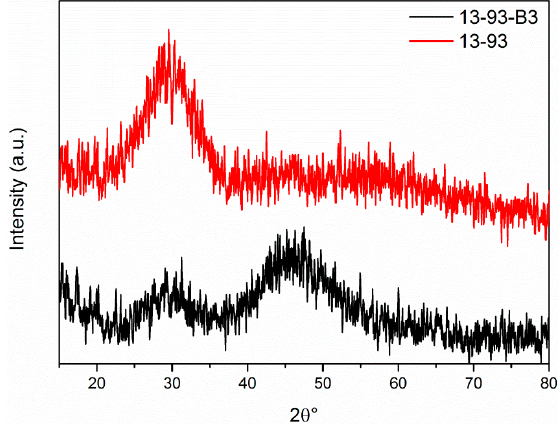
Figure 2. XRD patterns of 13-93 and 13-93-B3 BG targets material and deposited films.